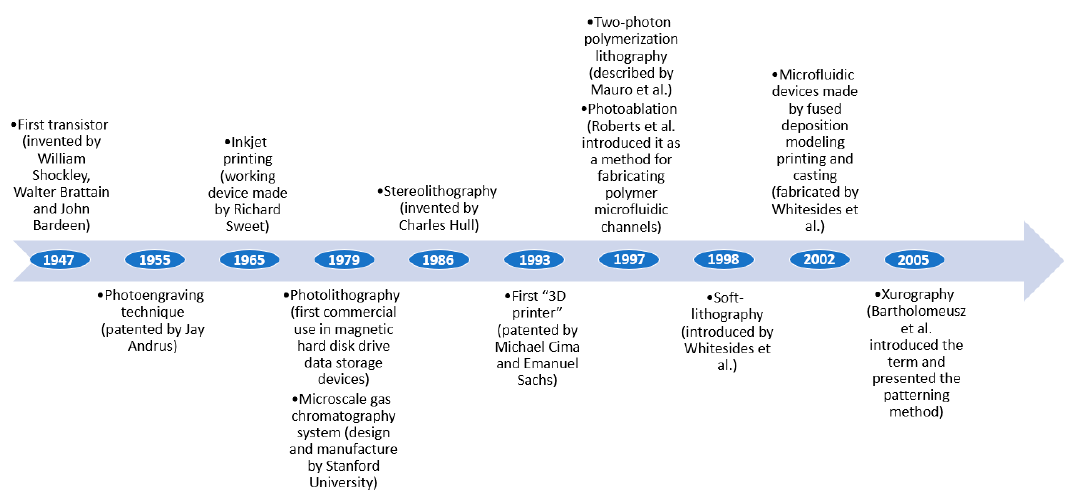
Figure 1. Important benchmarks in the evolution of microfluidic device fabrication. Created based on information from the literature references [52–57].